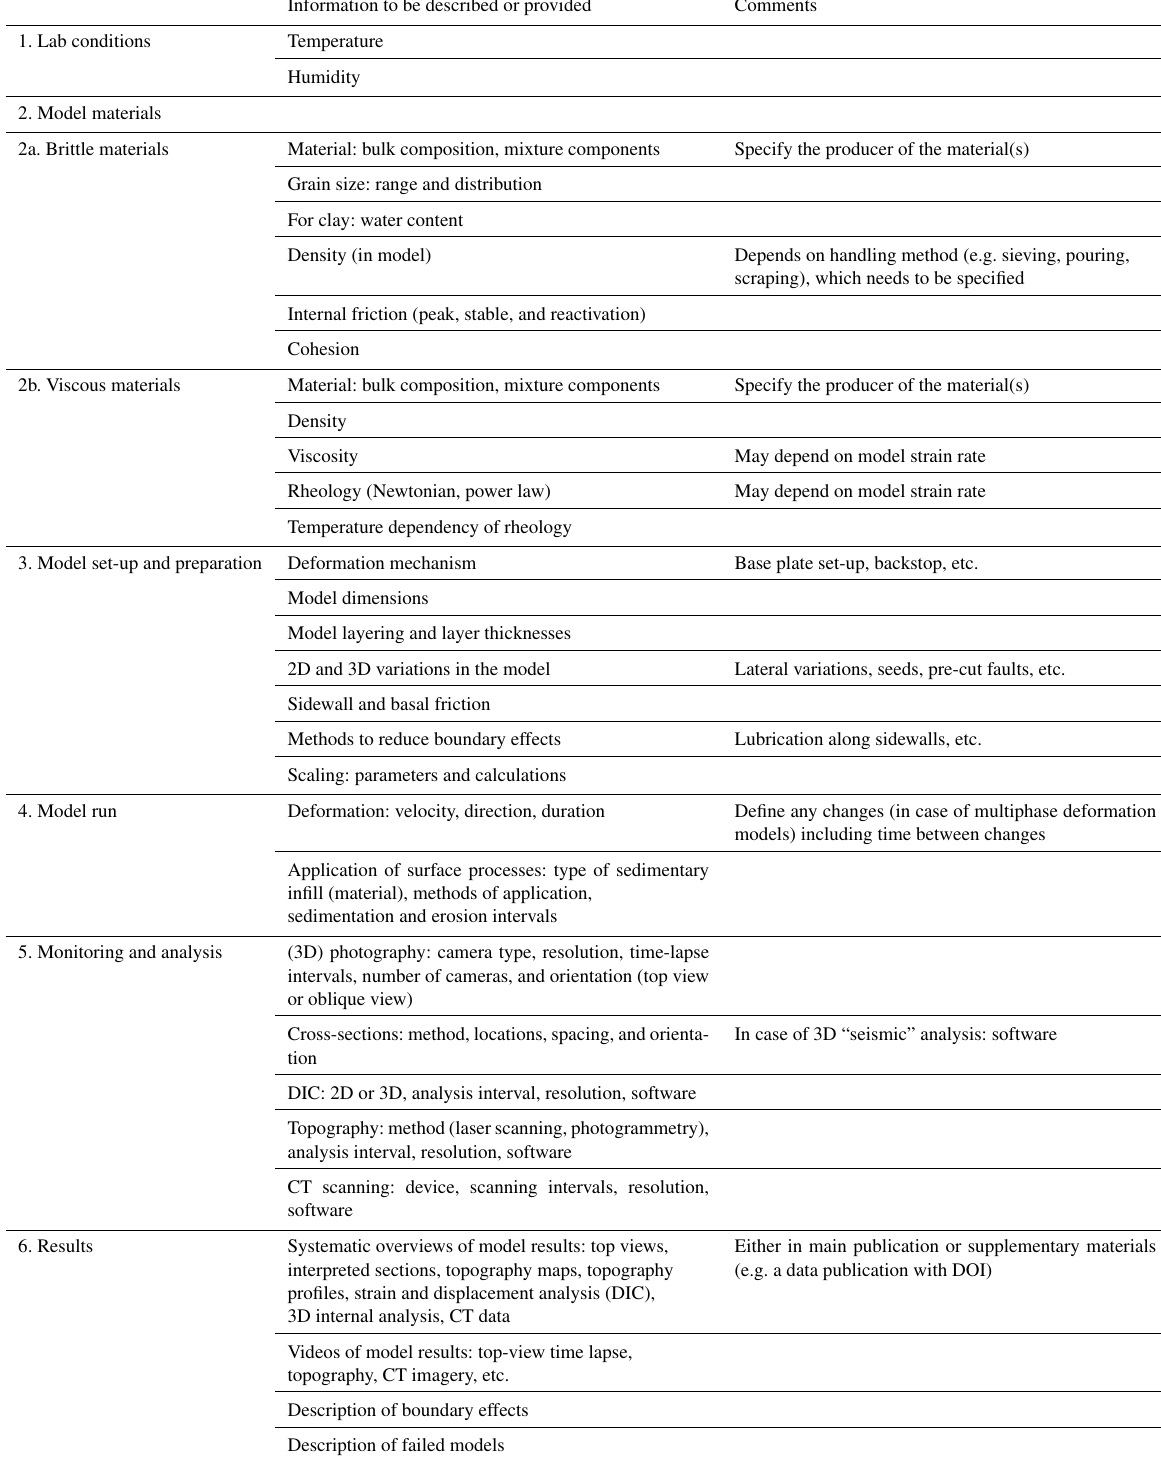
Table A1. Checklist of parameters to report when describing analogue models of tectonic processes. Information to be described or